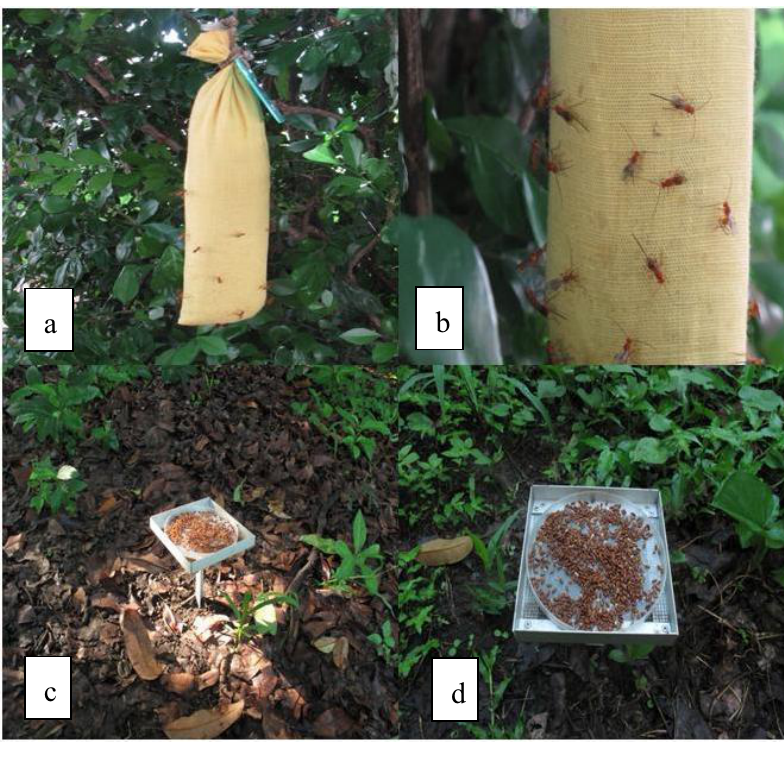
Figure 2. Different devices for evaluating parasitoid presence or activity in the field using irradiated host larvae or pupae. ( a (cid:12)(cid:3)(cid:179)(cid:54)(cid:68)(cid:88)(cid:86)(cid:68)(cid:74)(cid:72)(cid:180)(cid:3)(cid:87)(cid:85)(cid:68)(cid:83)(cid:3)(cid:90)(cid:76) th 200 irradiated larvae and diet for D. longicaudata evaluations, ( b ) D. longicaudata females ovipositing into hosts within the trap, c and d) two views of traps with approximately 1,000 irradiated pupae and vermiculite used for evaluation of pupal